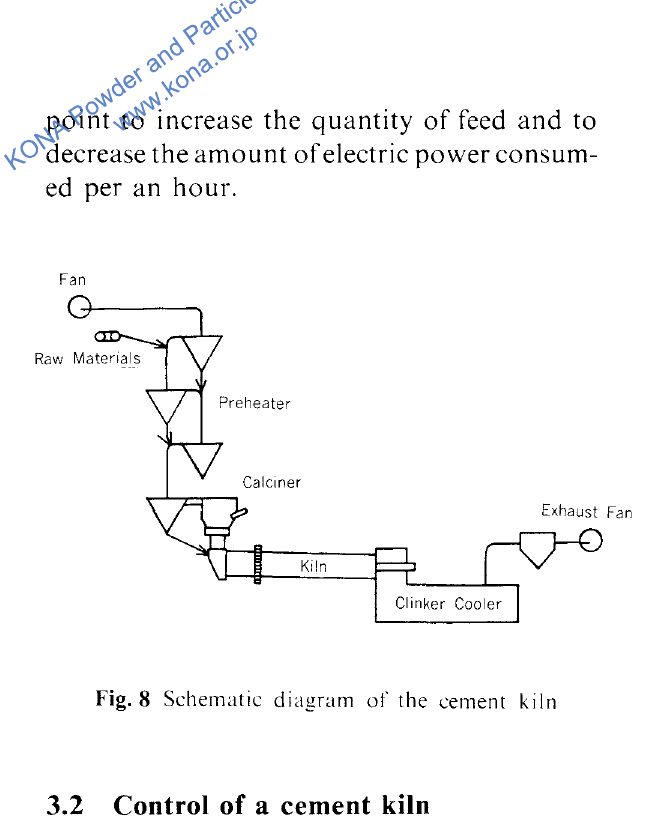
Fig. 8 Schematic diagram of the cement